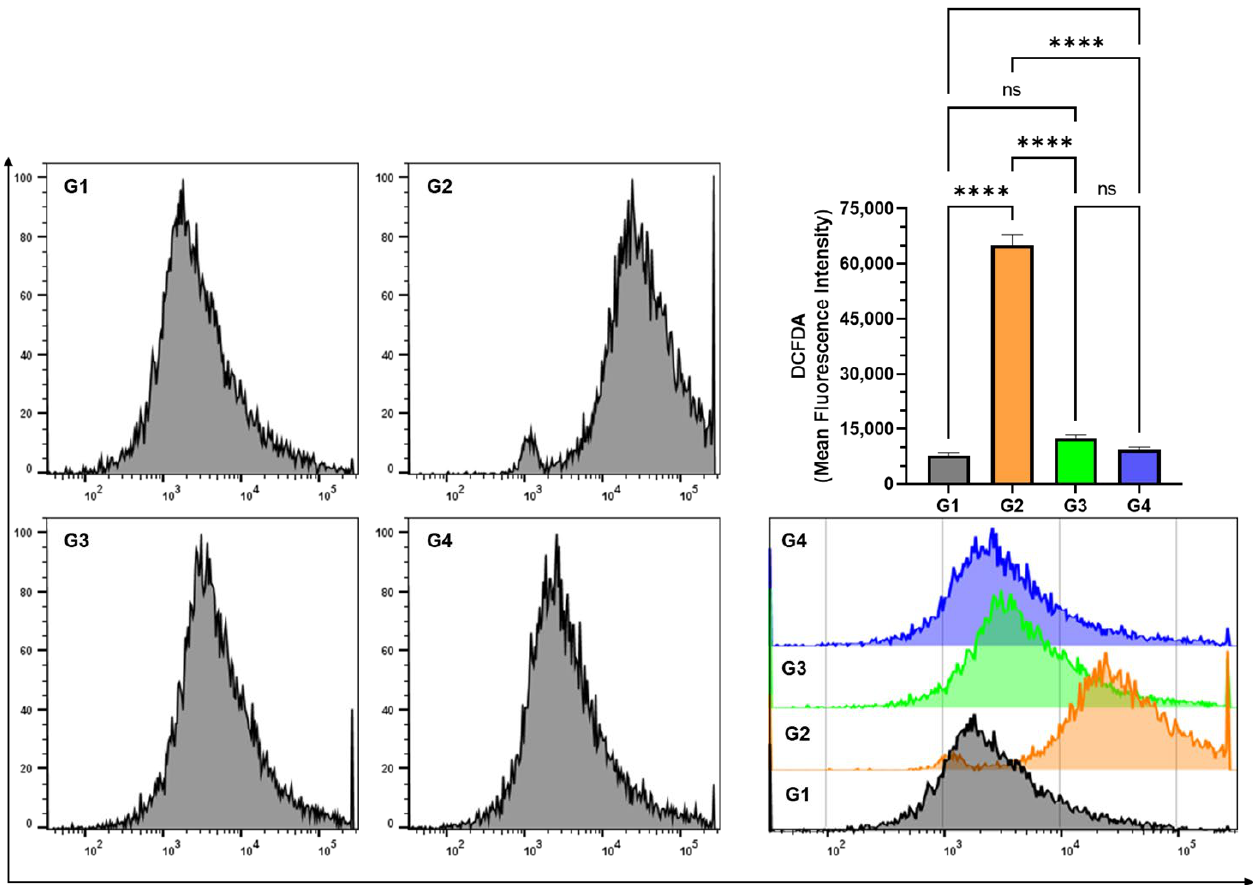
Figure 7. Effect of AAE on cellular ROS in the lung cells by DCFDA using flow cytometry. The values are given as the SEM of three independent experiments. ns No significance within the groups; **** significant difference between the groups, p -value < 0.0001.